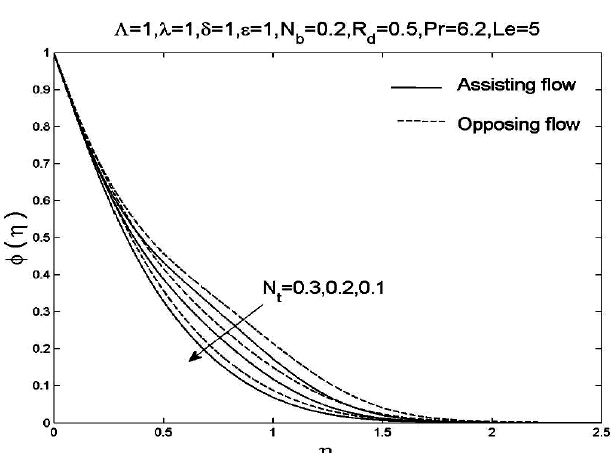
Fig. 24. The effect of the thermophoresis parameter Nt on the concentration profiles ( ) φη .